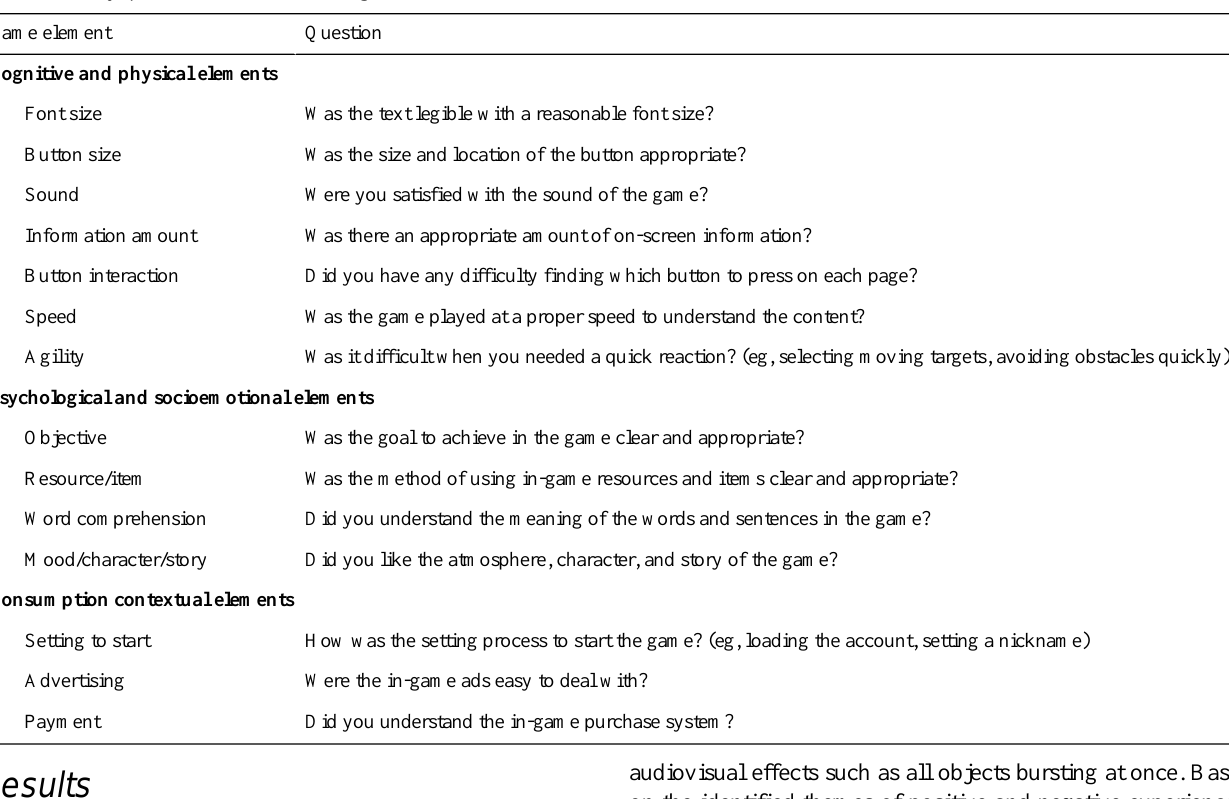
Table 4. Survey questionnaires for measuring the satisfaction